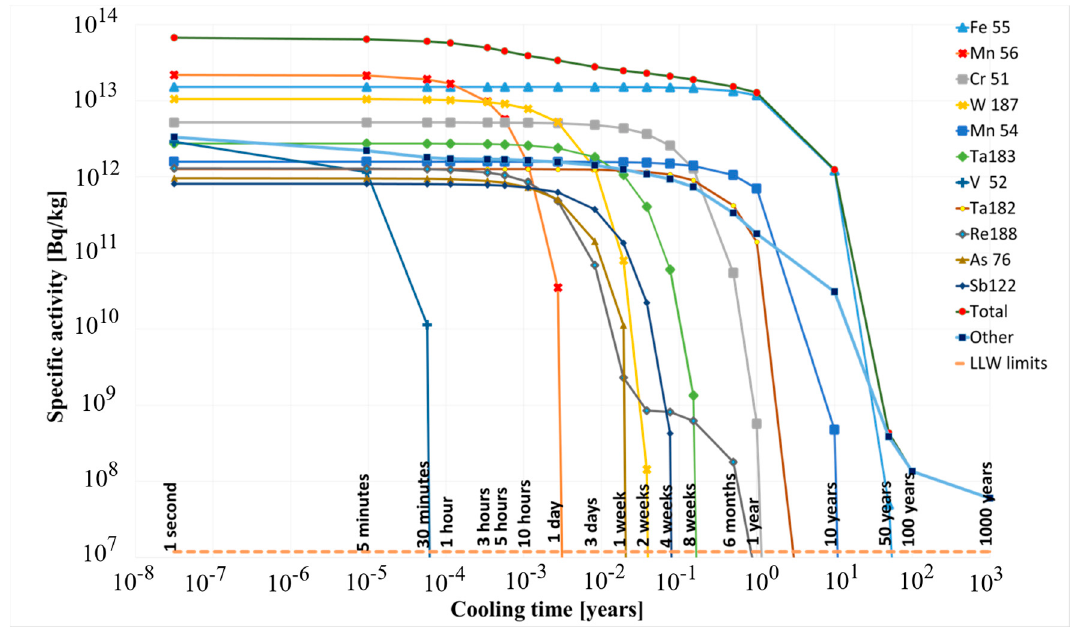
Figure 6. The specific activity of Eurofer in the liner and reflector plates (HCPB concept) with Low Level Waste (LLW) line. Activation inventories calculations for water show 16 N (half-life: 7.13 s, β -) as